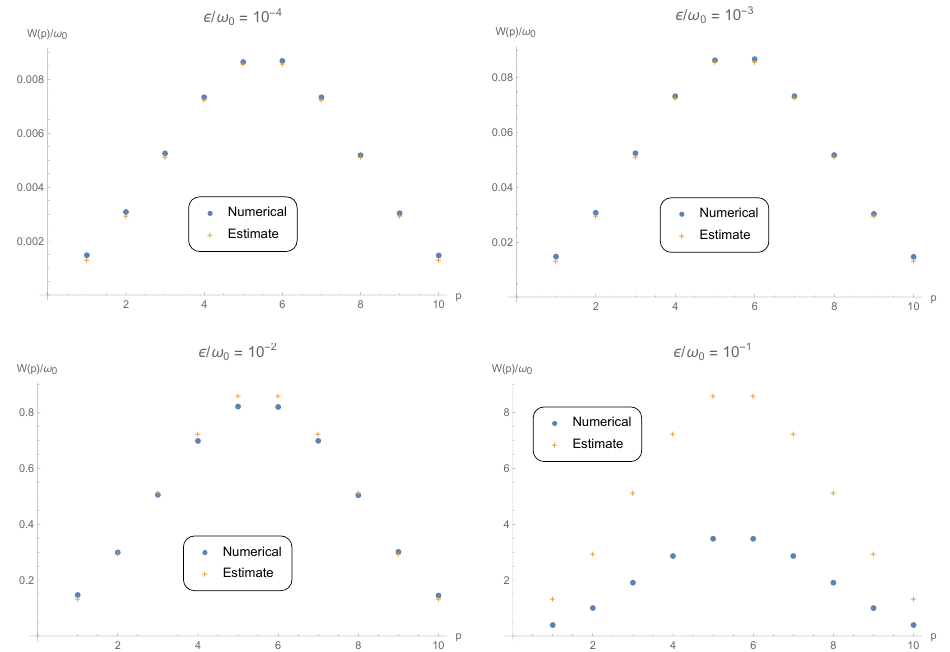
Figure 22 . Above are plots of the width in the spread of degenerate energy states within the p -th degenerate sector at various coupling regimes ranging from the weakly coupled regime with (cid:15)/ω 0 = 10 − 4 to the strongly coupled regime with (cid:15)/ω 0 = 10 − 1 . The solid circles are numerical computations of the width and the “ + ” is the expectation of the width (Given by eq. (4.16)) from first order degenerate perturbation